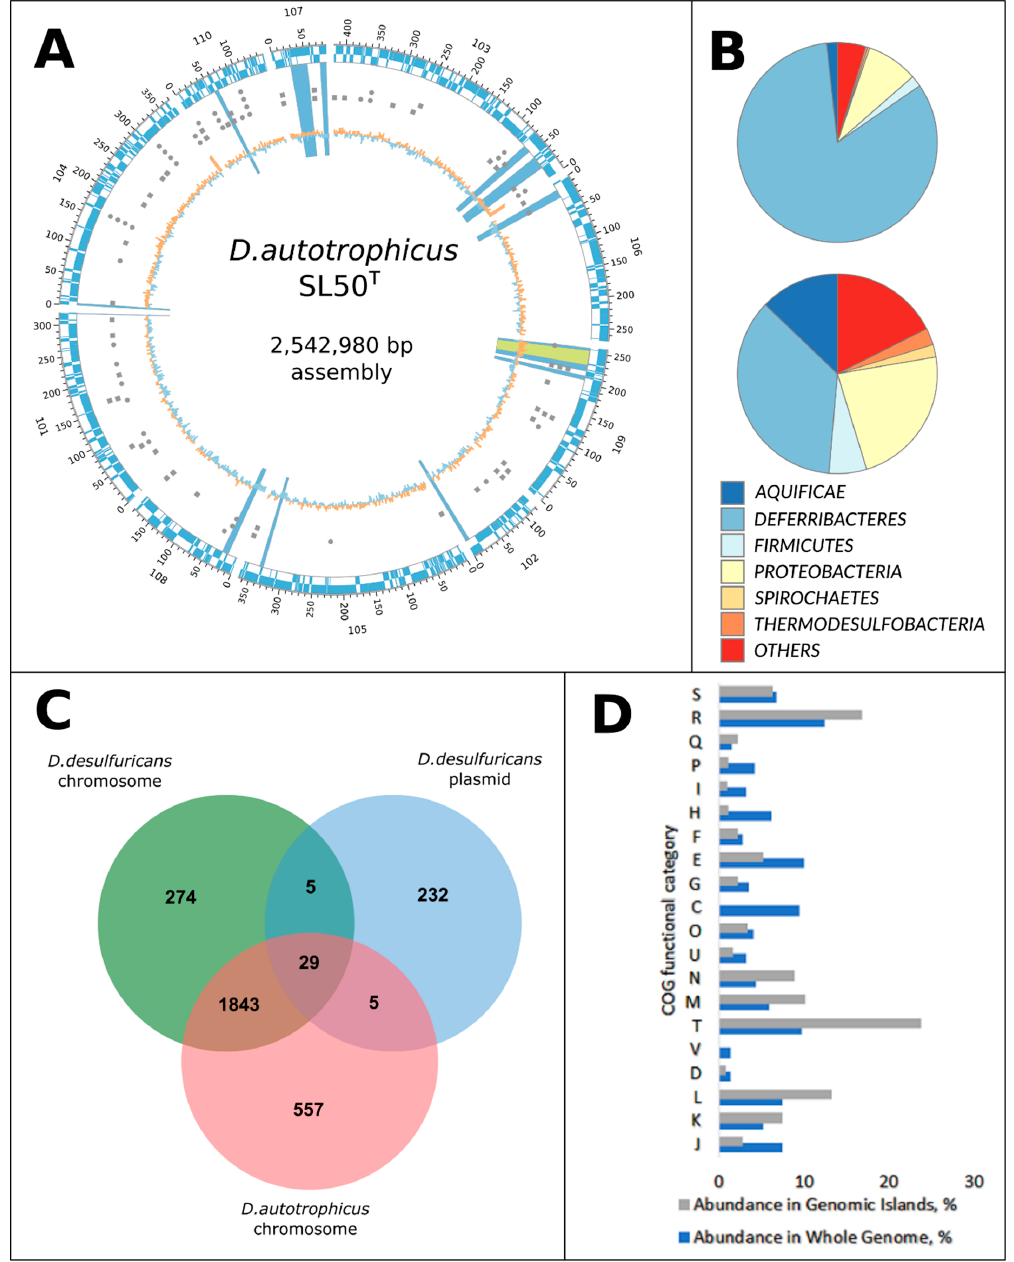
Figure 1. Genomic features of Deferribacter autotrophicus SL50 T . ( A ) Circular map of the genomic features of D. autotrophicus . Rings from outside to inside: contig ID (corresponding to the locus number suffix, e.g. Ga0300908_101); genomic coordinates in the corresponding contig; plus-strand CDS (light blue); minus-strand CDS (light blue); GI-related features—tRNAs (grey circles) and transposases (grey squares); GC-content, relative to the average GC-value. Genomic islands are shown as light-blue sectors; prophage is shown as the light green sector. Contigs of D. autotrophicus